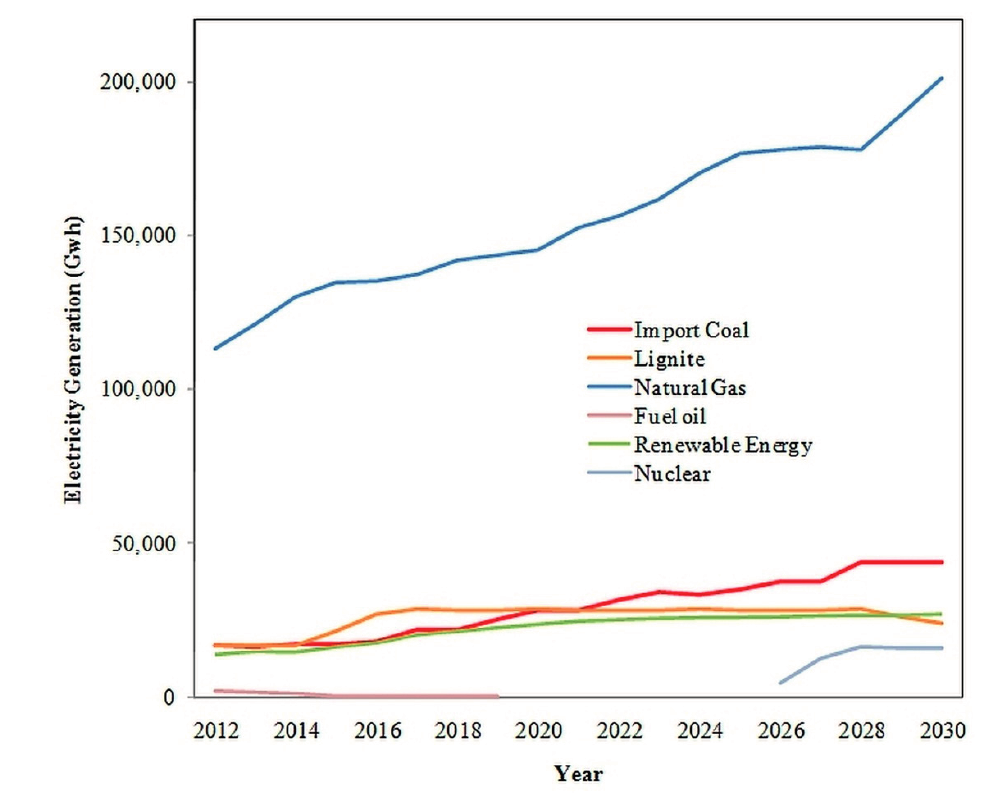
Figure 2. Projection of Electricity Generation by Fuel during